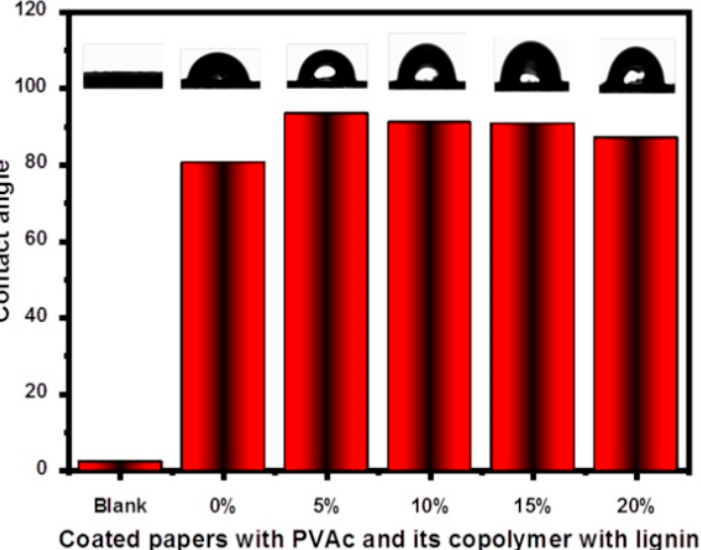
Figure 2. Electron micrographs of the surface of the blank paper ( A ) and paper coated with